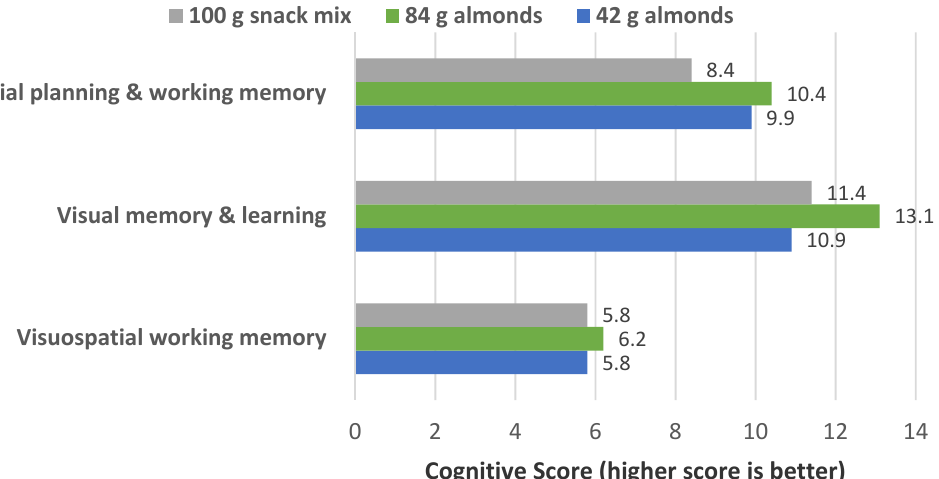
Figure 24. Change in cognitive measures after 6 months for almonds and mixed snacks with 84 g of almonds (3 servings/day) significantly improving working and visual memory cognitive measures ( p < 0.017) compared to the control snack mix [81].